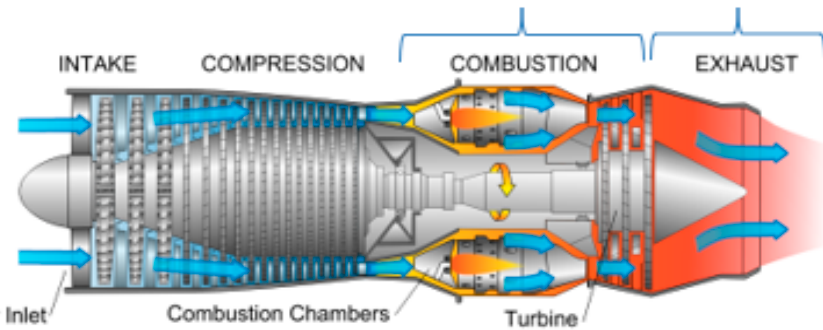
Figure 6. Representation of CMC component parts in a gas turbine engine.